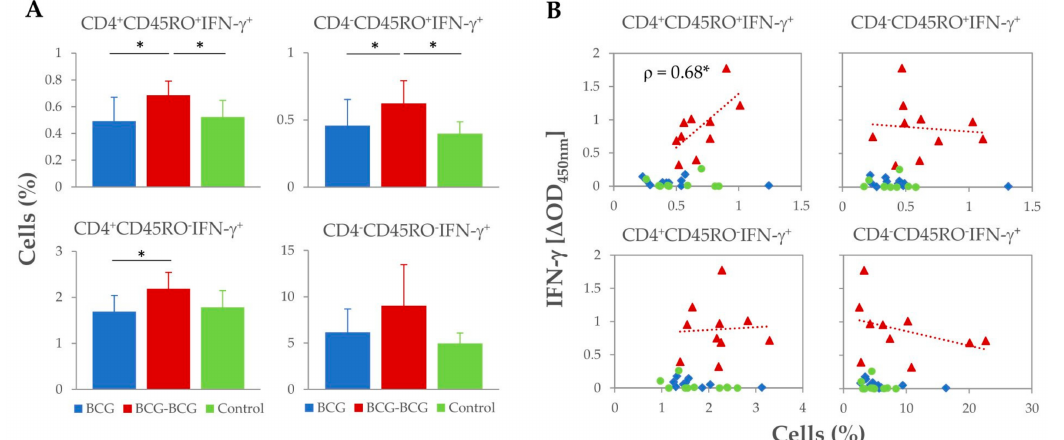
Figure 3. Proportion of M. bovis tuberculin (PPD-B)-specific IFN- γ + T-cell subsets isolated from peripheral blood at week 59 (3 weeks after revaccination). ( A ) Frequency (%) of IFN- γ + lymphocyte subsets. * p < 0.05, Kruskal–Wallis test with post-hoc Wilcoxon test. ( B ) Correlation of IFN- γ + lymphocyte subsets frequencies with IFN- γ released after whole blood stimulation with PPD-B at week 59. * p < 0.05 (Spearman ρ =